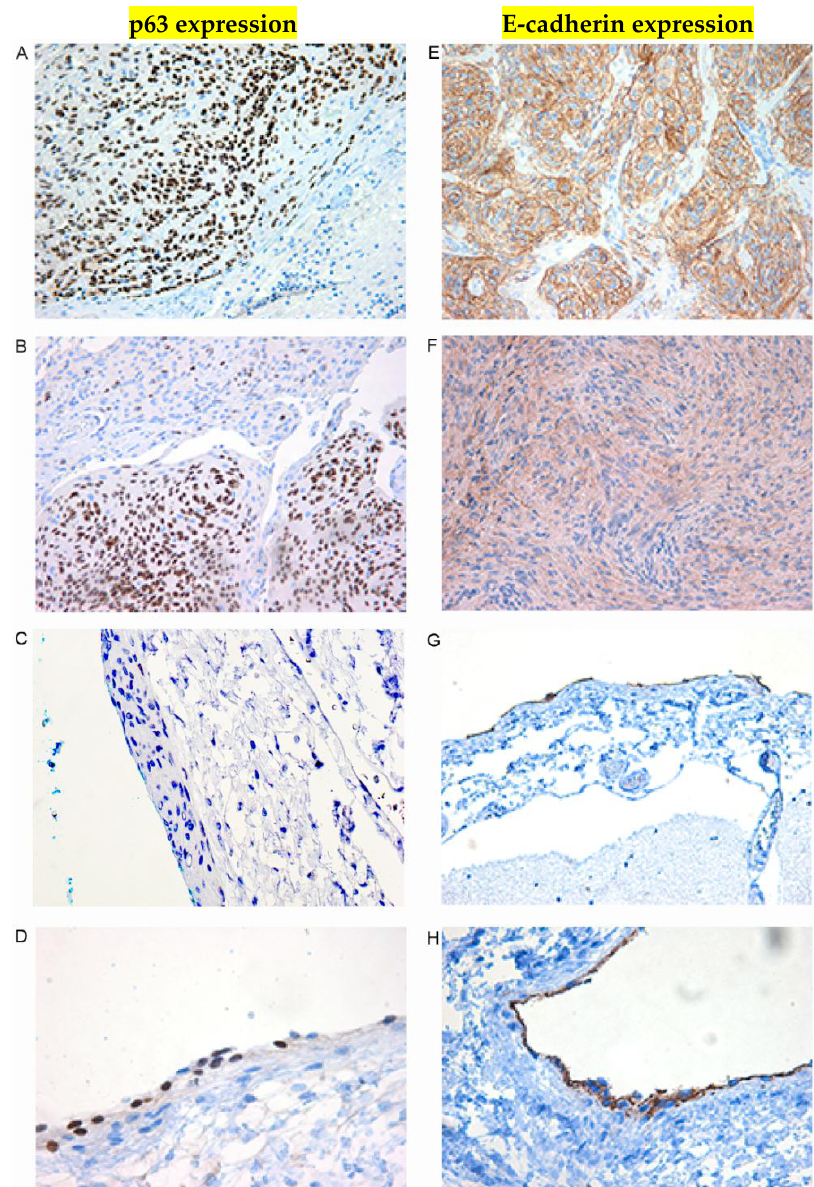
Figure 3. Immunohistochemistry of p63 ( A – D ) and E-cadherin ( E – H ) in meningioma ( A , B , E , F ) compared to normal arachnoid membranes ( C , D , G , H ). ( A ) Strong nuclear signal of p63 expression in this section of the tumor (200 ˆ ); ( B ) Another tumor with both a moderate and a low signal for the nuclear p63 expression; ( C ) Immunohistochemistry p63 in arachnoid membrane from cadaver with no meningioma. No nuclear p63 expression in cells of the arachnoid membrane was observed in four different arachnoid autopsies as represented in C, at magnification of 400 ˆ ; ( D ) Immunohistochemistry p63 in arachnoid from one sample with no meningioma a nuclear p63 expression in the external cap cells 400 ˆ ; ( E ) Strong cytoplasmic signal of E-cadherin expression in this tumor (200 ˆ ); ( F ) A tumor section with low E-cadherin expression; ( G ) Immunohistochemistry E-cadherin in arachnoid membrane from cadaver with no meningioma. Cytoplasmic E-cadherin expression is also limited to the outer layer of the arachnoid (200 ˆ ); ( H ) Immunohistochemistry E-cadherin in arachnoid from cadaver with no meningioma in higher magnification (400 ˆ